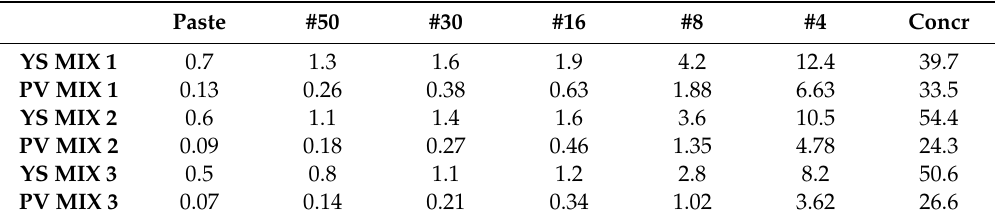
Table 10. Measured (paste and concrete) or calculate (mortar) rheological properties of each hypothetical layer in the interface rheometer.